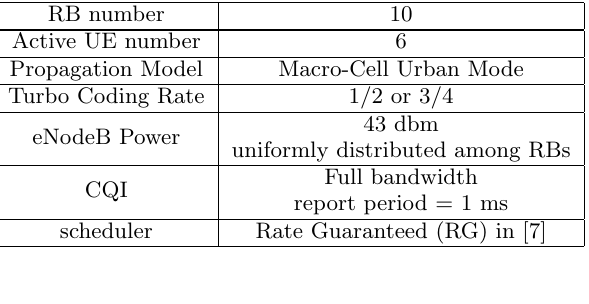
Table 2: Average Bit Rate (kbps) for each segment